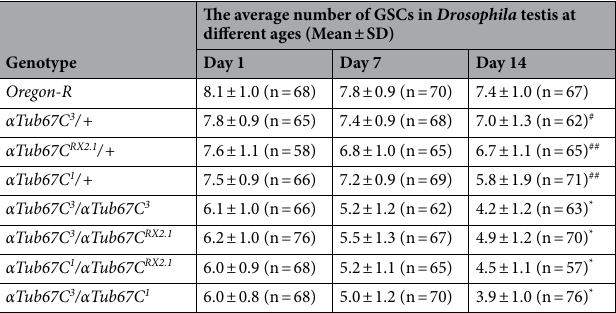
Table 1. Phenotypic assay for αTub67C mutant flies. SD, standard deviation. n, Number of testes examined. # P > 0.05; ## P < 0.05; * P < 0.01, unpaired t-test, compared with Oregon-R at day 14.